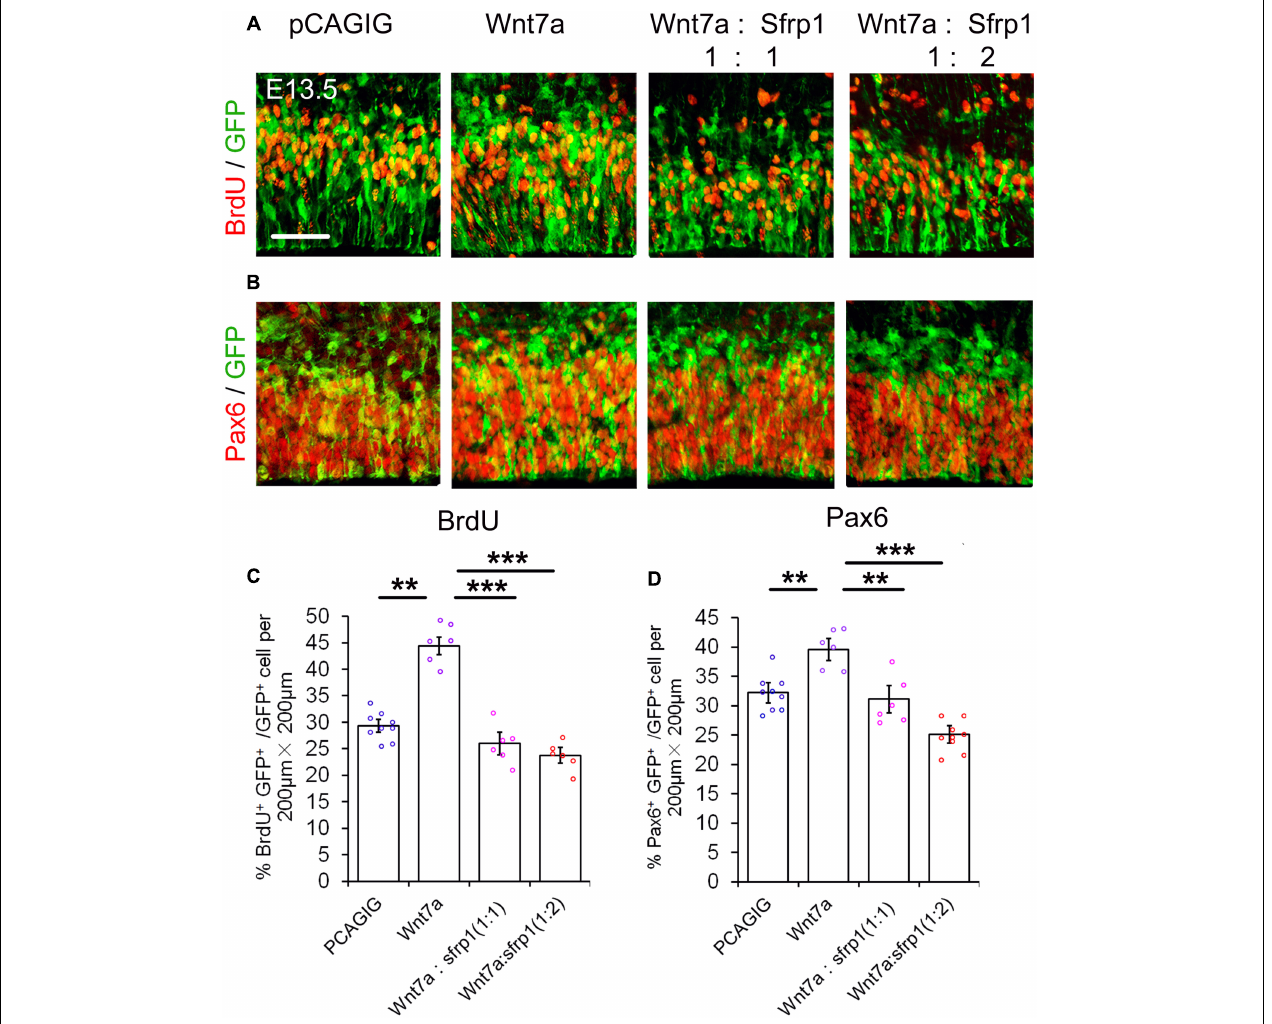
FIGURE 5 | Sfrp1 suppresses Wnt7a activity in neural progenitor proliferation dosage-dependent manner. (A,B) Co-expression of Sfrp1 and Wnt7a dampened the effect of Wnt7a in expanding neural progenitors at E13.5. (C,D) The numbers in BrdU + /GFP + and Pax6 + /GFP + neural progenitors showed a decreasing trend with a proportional increase of Sfrp1 ( Wnt7a : Sfrp1 = 1:1 vs. Wnt7a : Sfrp1 = 1:2). Values represent mean ± SEM, and each dot represents a data point of the marker + GFP + /GFP + % in each section (200 µ m × 200 µ m). n = 3, at least two sections from each brain. ∗∗ P < 0.01; ∗∗∗ P < 0.001; unpaired Student’s t -test. Scale bar = 50 µ